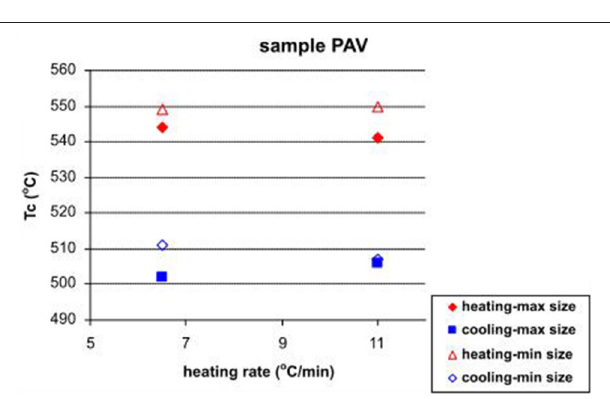
FIGURE 6 | Calculated Curie temperatures (Tc) from heating and cooling curves with large and small sample sizes as a function of the heating rate for sample